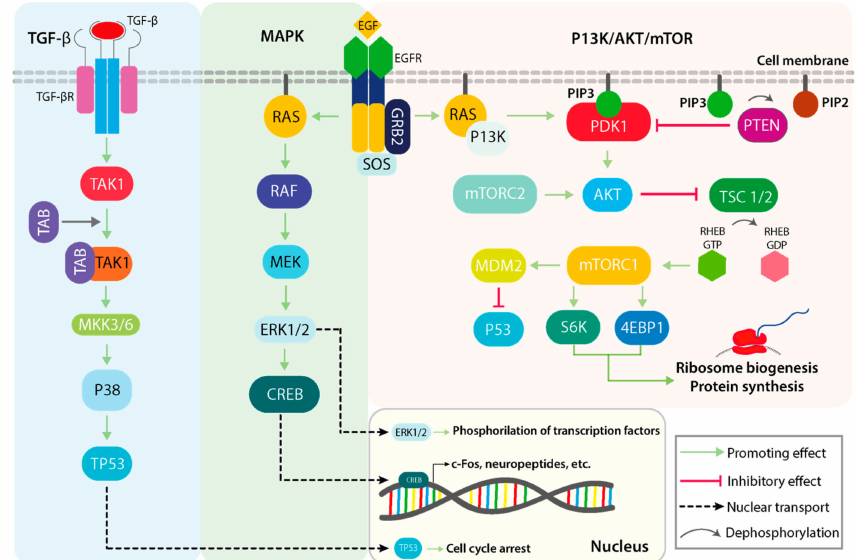
Figure 1. Parallel outline of several physiological roles of the TGF β / p38, mitogen-activated protein kinase (MAPK), and P13k / AKT / mTOR signaling pathways. The p38 mitogen-activated kinase can be activated following upstream cytokine stimulation of the TGF β pathway, which can subsequently activate TP53 in normal physiological conditions. TGF β activation of p38 is not dependent on canonical SMAD signaling, but rather on the TAB / TAK1 complex and the MKK3 / 6 mitogen-activated protein kinase kinases. The canonical MAPK kinase pathway initiates with an extracellular stimulus in the form of growth factors (GFs) that bind and activate receptor tyrosine kinases (RTKs) on the cell membrane. Downstream activation of RAS, RAF and MEK in that order converge in the activation of the ERK1 / 2 transcription factor activator. The P13K / AKT / mTOR cascade can also be activated via RTKs and RAS, and its main implications are related to metabolic signaling and protein synthesis that sustain